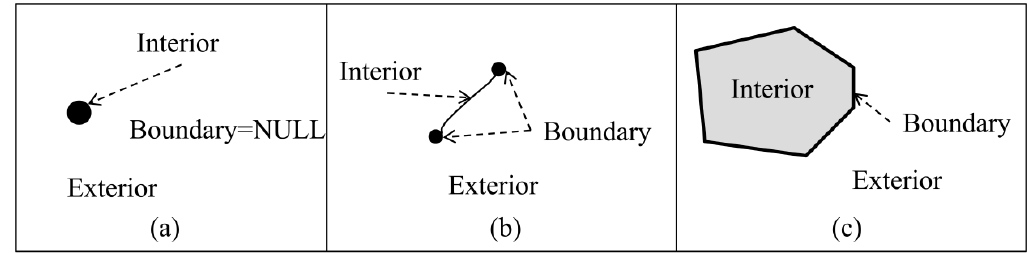
Figure 1. Spatial objects including interior, boundary and exterior. ( a ) A point with its interior, boundary and exterior. ( b ) A line with its interior, boundary and exterior. ( c ) A region with its interior, boundary and exterior.